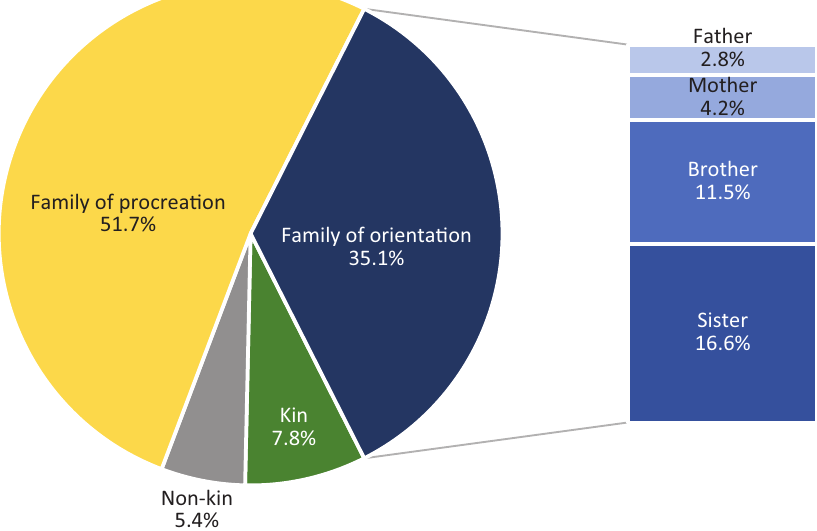
Figure 1. Significant persons that could provide support with care for elderly parents. Source: Data derived from the 2018 representative survey Migration and Family Processes: Representative Study ( N = 1005) and complemented with informa‐ tion by 910 respondents ( N / N = 95); there were about 1092 significant persons who could provide such care (27.9% of all significant persons